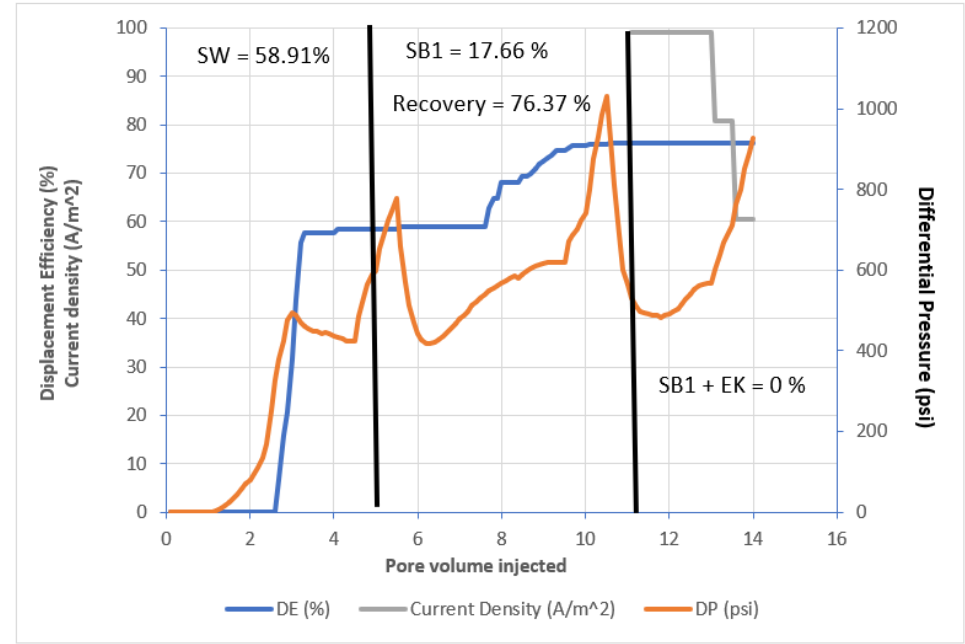
∆ P), Current Density vs. Pore Volume Injected for CF2. Figure 3. DE, DP (ΔP), Current Density vs. Pore Volume Injected for CF2 . Figure 3. DE, DP ( CF3